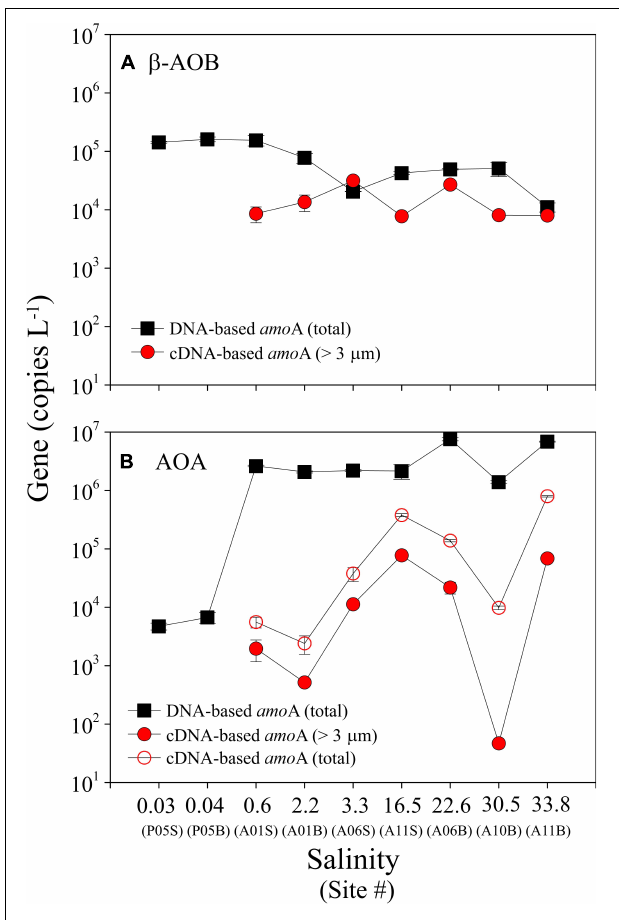
FIGURE 3 | Total abundance of the DNA-based and cDNA-based amo A genes of β -AOB (A) and AOA (B) on three size-fractioned particles ( > 3.0 µ m, 0.45–3.0 µ m, and 0.22–0.45 µ m) along the salinity gradient in the PRE. Note that the cDNA-based β -AOB amo A genes were only detected on particles of > 3.0 µ m (red solid circle). cDNA at site P05 was not studied because these samples were not stored with RNAlater (see text). The suffixes “S” and “B” of site information represent the surface and bottom samples at each site,